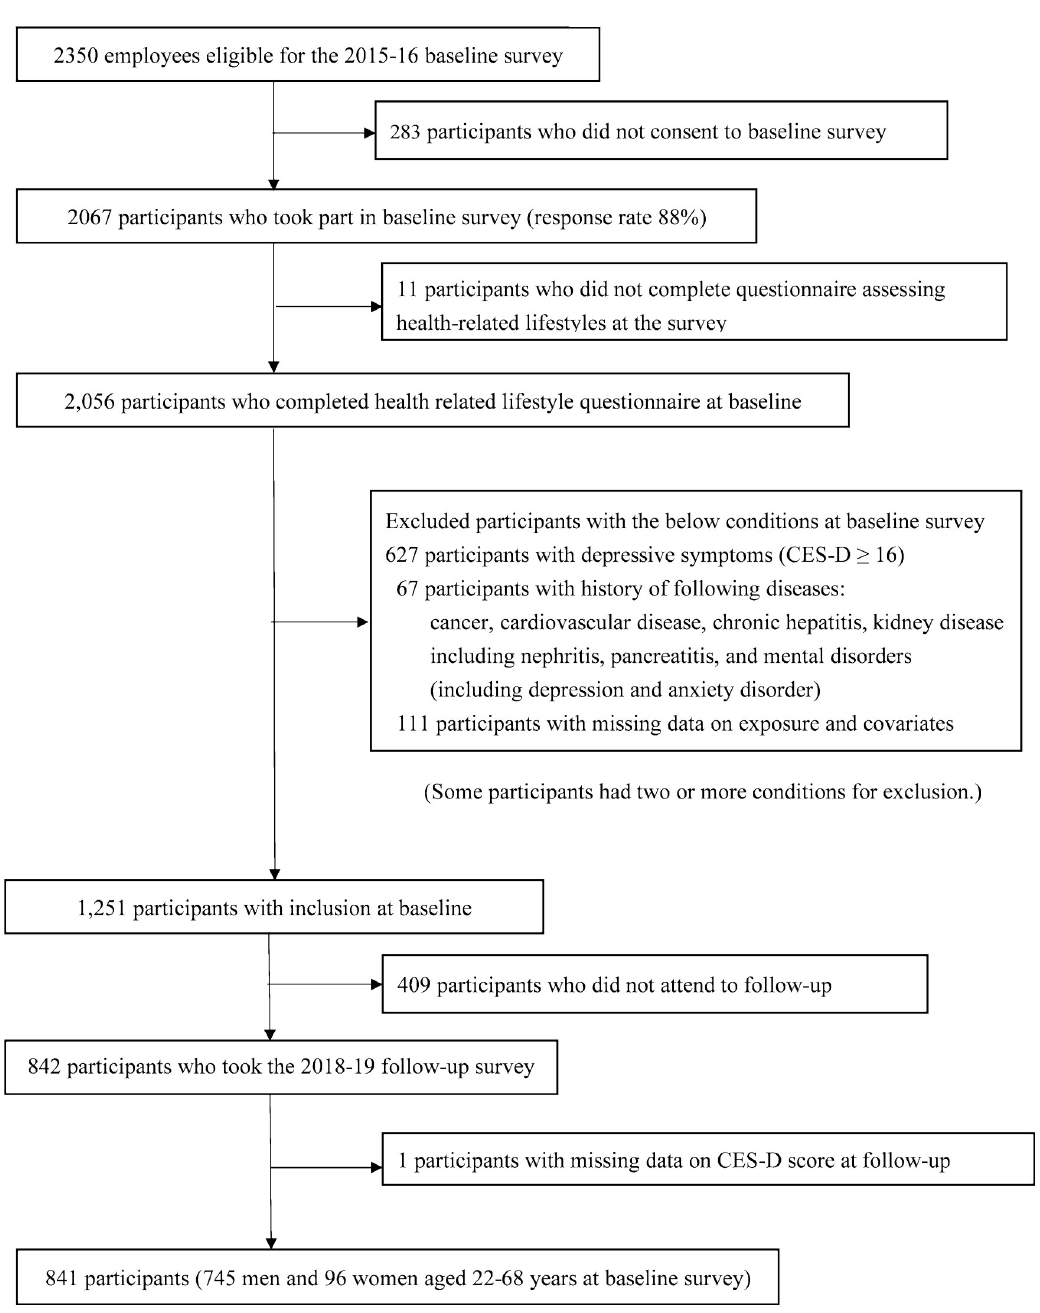
Fig 1. Flowchart of study protocol. Abbreviation: CES-D, Center for Epidemiologic Studies Depression Scale. box to a laboratory. Blood was centrifuged for 15 min to separate serum, and the serum sample was stored at -80˚C until the analyses were performed. Serum concentrations of amino acids were analyzed using liquid chromatography/mass spectrometry (LC/MS) at an external labora- tory (SRL, Tokyo Japan). Serum samples deproteinized using acetonitrile were centrifuged twice at 12,000 rpm for 10 min, and then the supernatant was aliquoted. The aliquoted samples were then separated on an Inertsil ODS-3 column (2.1 × 100 mm; GL Science, Tokyo, Japan)